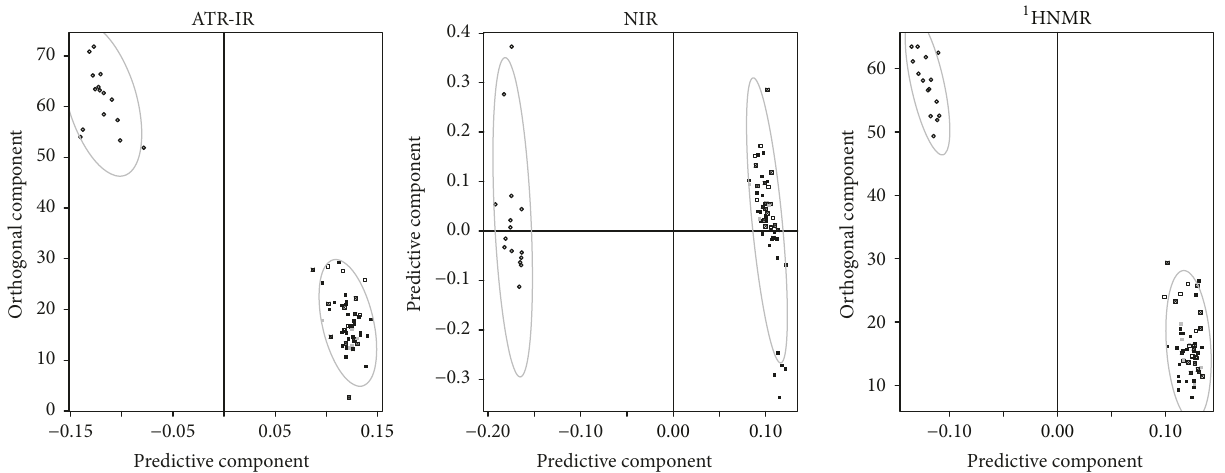
Figure 2: Scores plots of typical models for discrimination by species. These models were chosen from the top of the curves in Figure 1. By “typical” we mean that all models generated in the 7-fold validation presented pretty much the same behavior as the ones depicted. Squares: Arabica and circles: Robusta